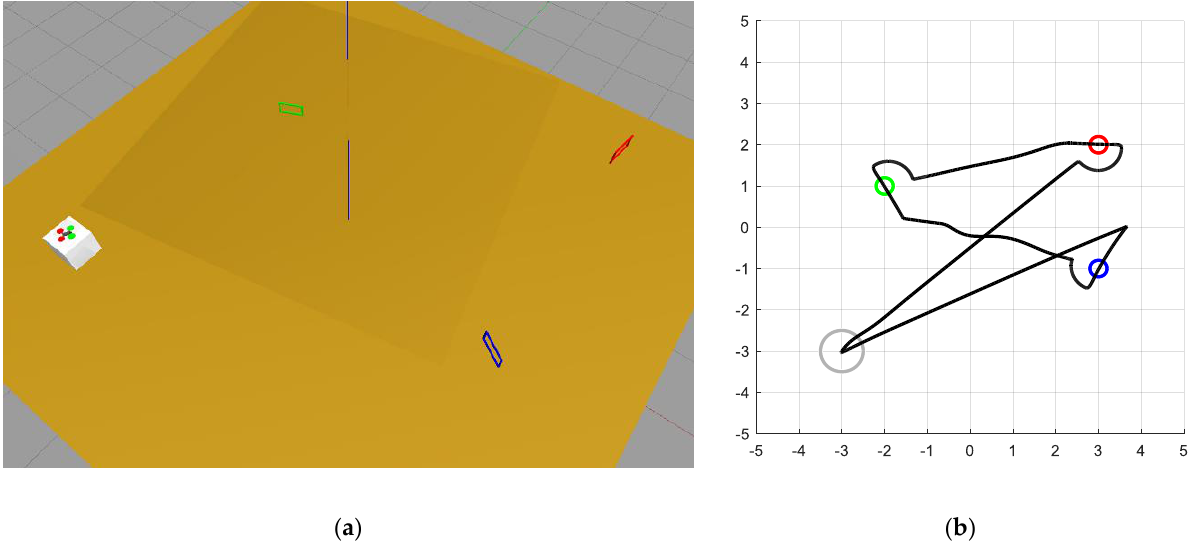
Figure 15. Test case 1: ( a ) simulated scenario (upper view); ( b ) path followed by the drone.